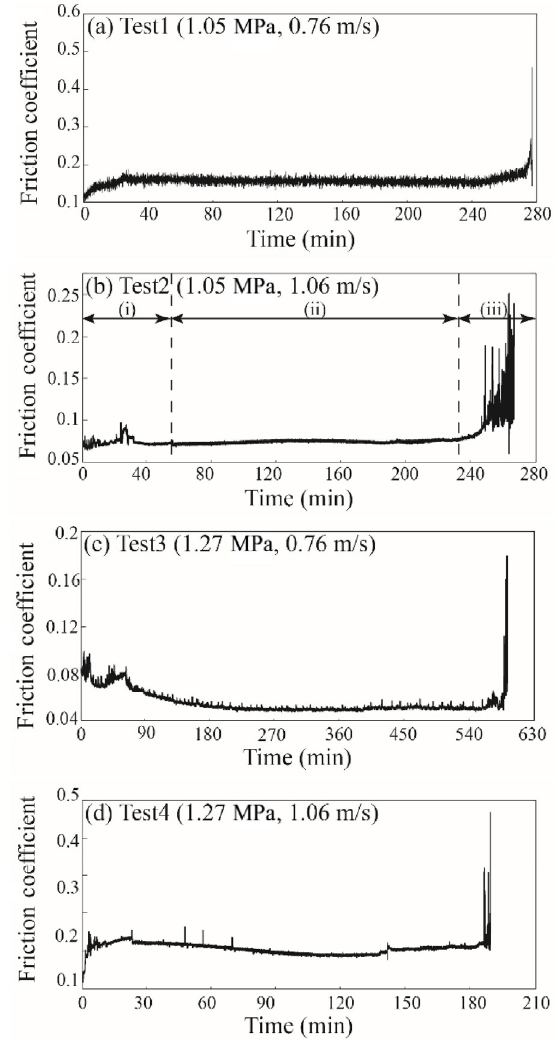
Fig. 3 COF signals during the rotating friction